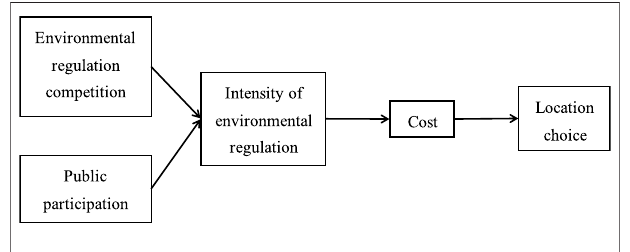
FIGURE 1 | ransmission path of enterprise location